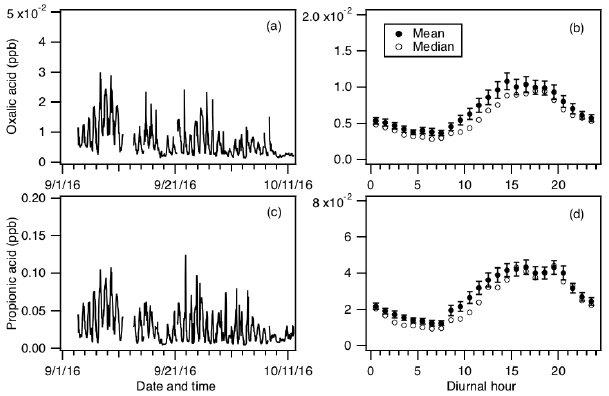
Figure 5. Time series of concentrations of (a) oxalic and (c) pro- pionic acids measured during the field study. All the data are dis- played as 1h averages. Their corresponding diurnal profiles are shown in panels (b) and (d) , respectively. The diurnal profile con- centrations represent averages in 1h intervals and the standard er- rors are plotted as error bars.